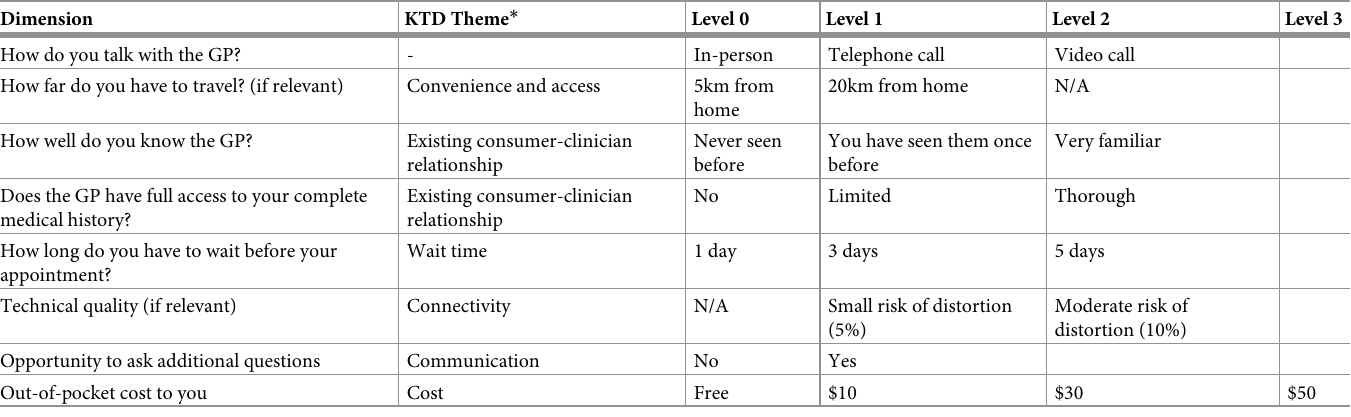
Table 1. Selected dimensions and